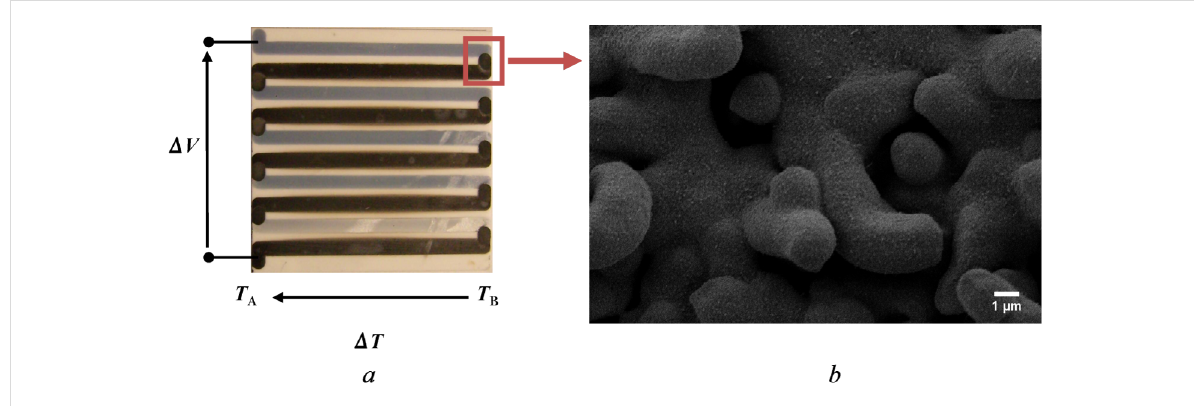
Figure 3: (a) Optical image of fabricated planar thermoelectric device based on ZnO and CuO nanowires. (b) SEM picture of the ZnO–CuO junction area.